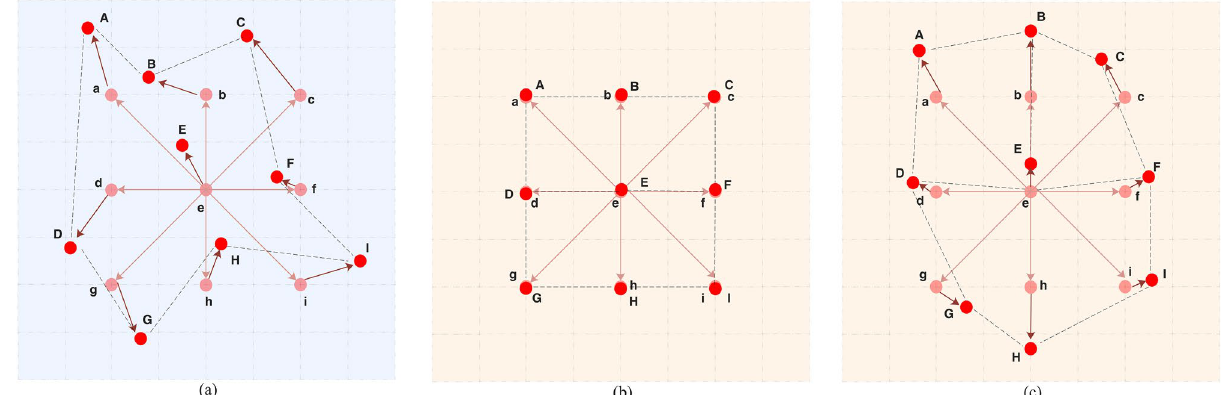
Figure 4. Conventional offset-based deformable convolution is presented in ( a ), and illustrations of the learning process of offsets in offset-decoupled deformable convolution are shown in ( b ) and ( c ). The sampling points are represented by the balls. Among them, the colors of typical convolution sampling points (a–i) and the actual sampling points (A–I) are pink and red, respectively. In addition, offsets are indicated by the dark red